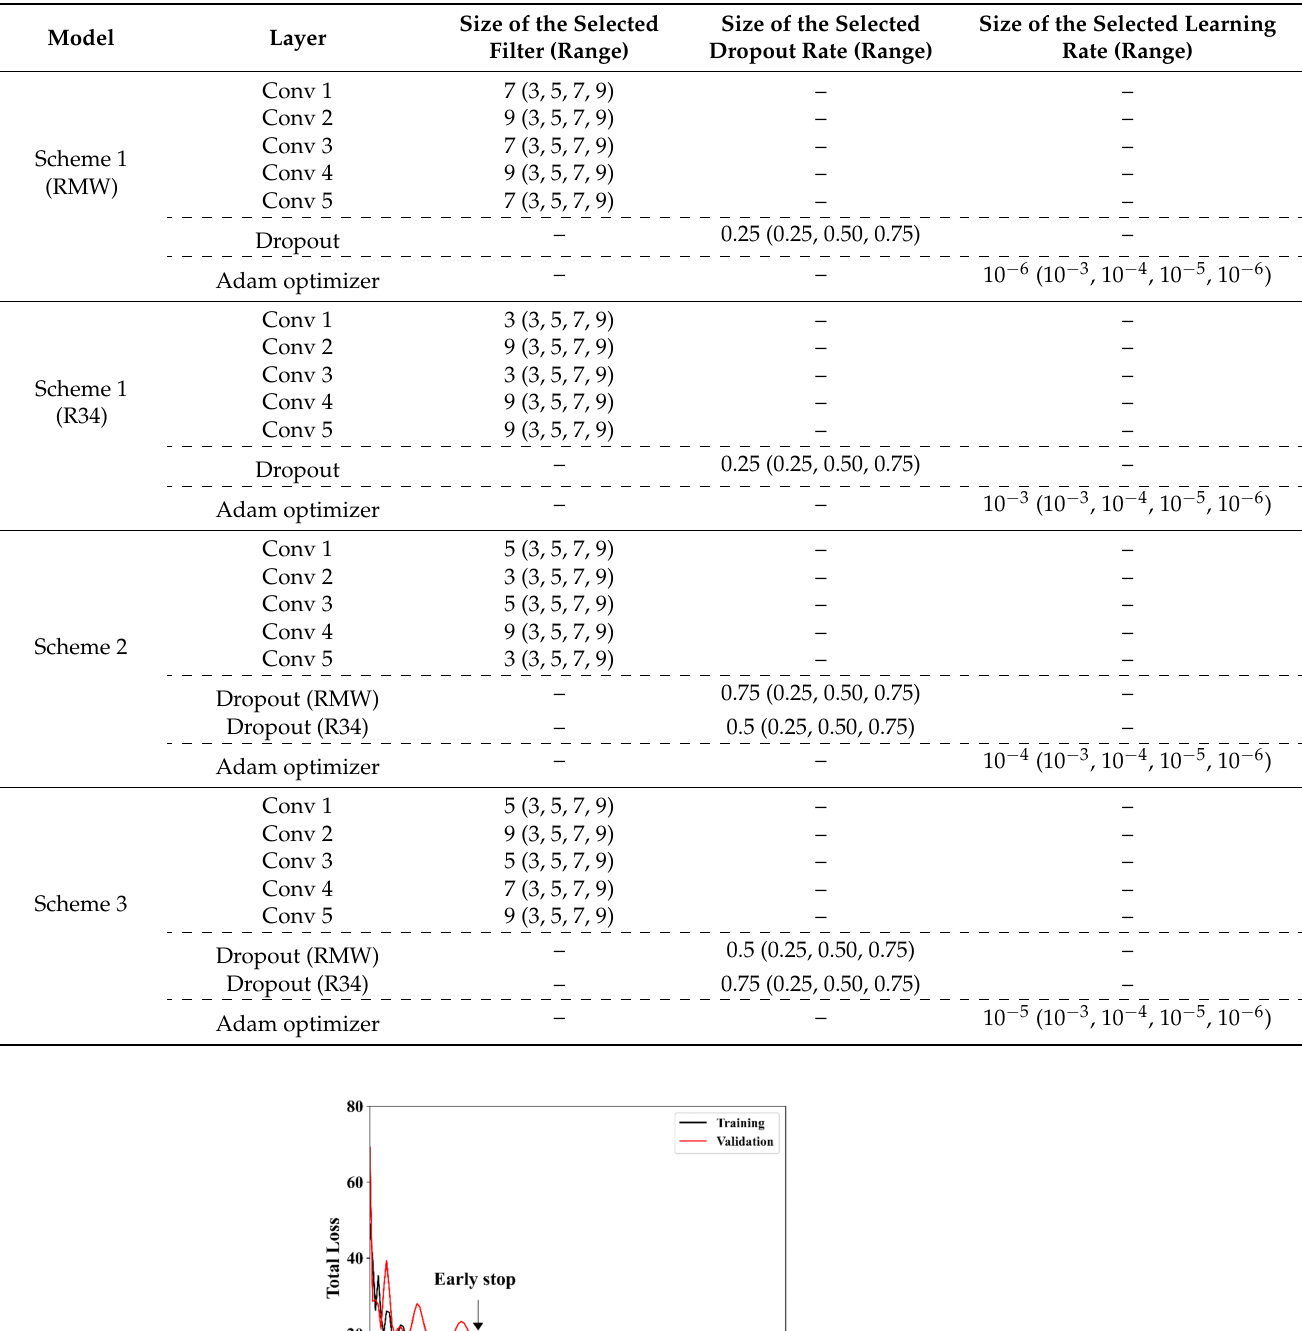
Table 2. Ranges of the hyperparameters used to select the optimal values for the three convolutional neural network models using the Keras tuner tool.